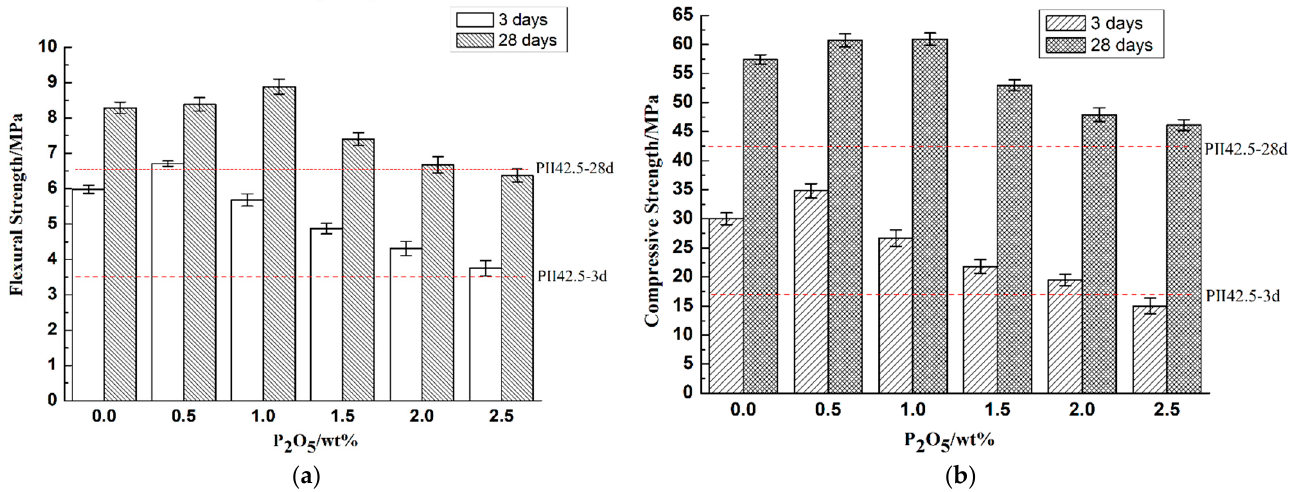
Figure 13. ( a ) Flexural and ( b ) Compressive strength of mortars cured in water for 3 and 28 days.